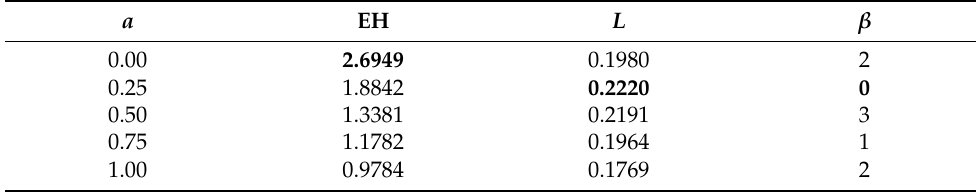
Table 2. Comparison of edge extraction under different values of a